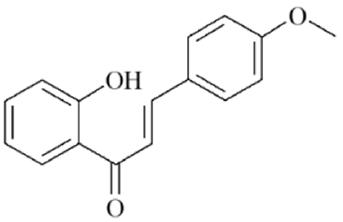
Figure 1. Chemical structure of 2-hydroxy-4’-methoxychalcone (AN07).